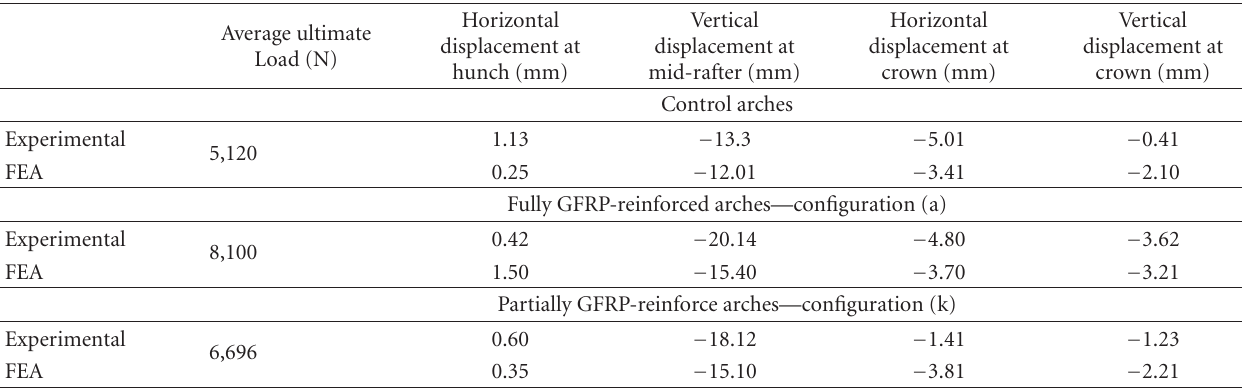
Table 4: Experimental and finite element analysis results of the control glulaminated curved beams and arches (average values of the test results described in the